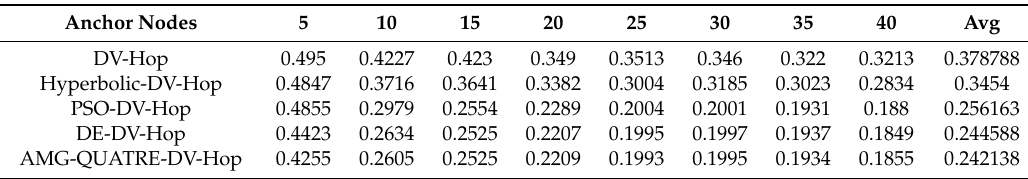
Figure 7. Comparison of location error of the applied AMG-QUATRE with the other methods for different anchor nodes. Table 6. Comparison of location errors of the applied AMG-QUATRE with the other methods for different anchor nodes.